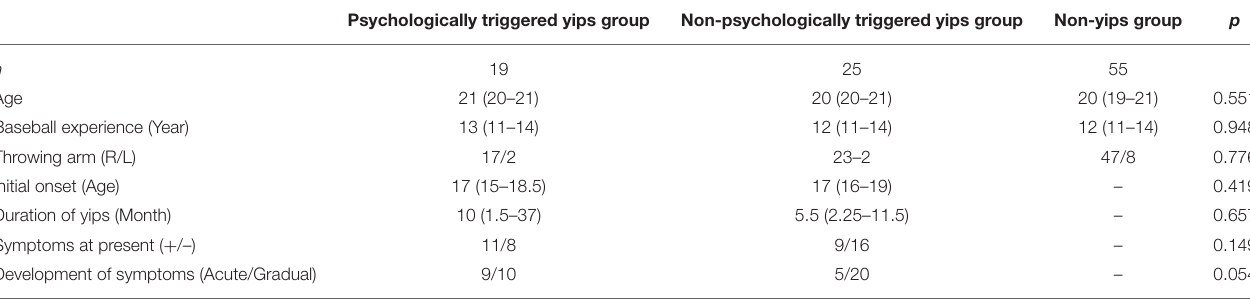
TABLE 1 | Participant